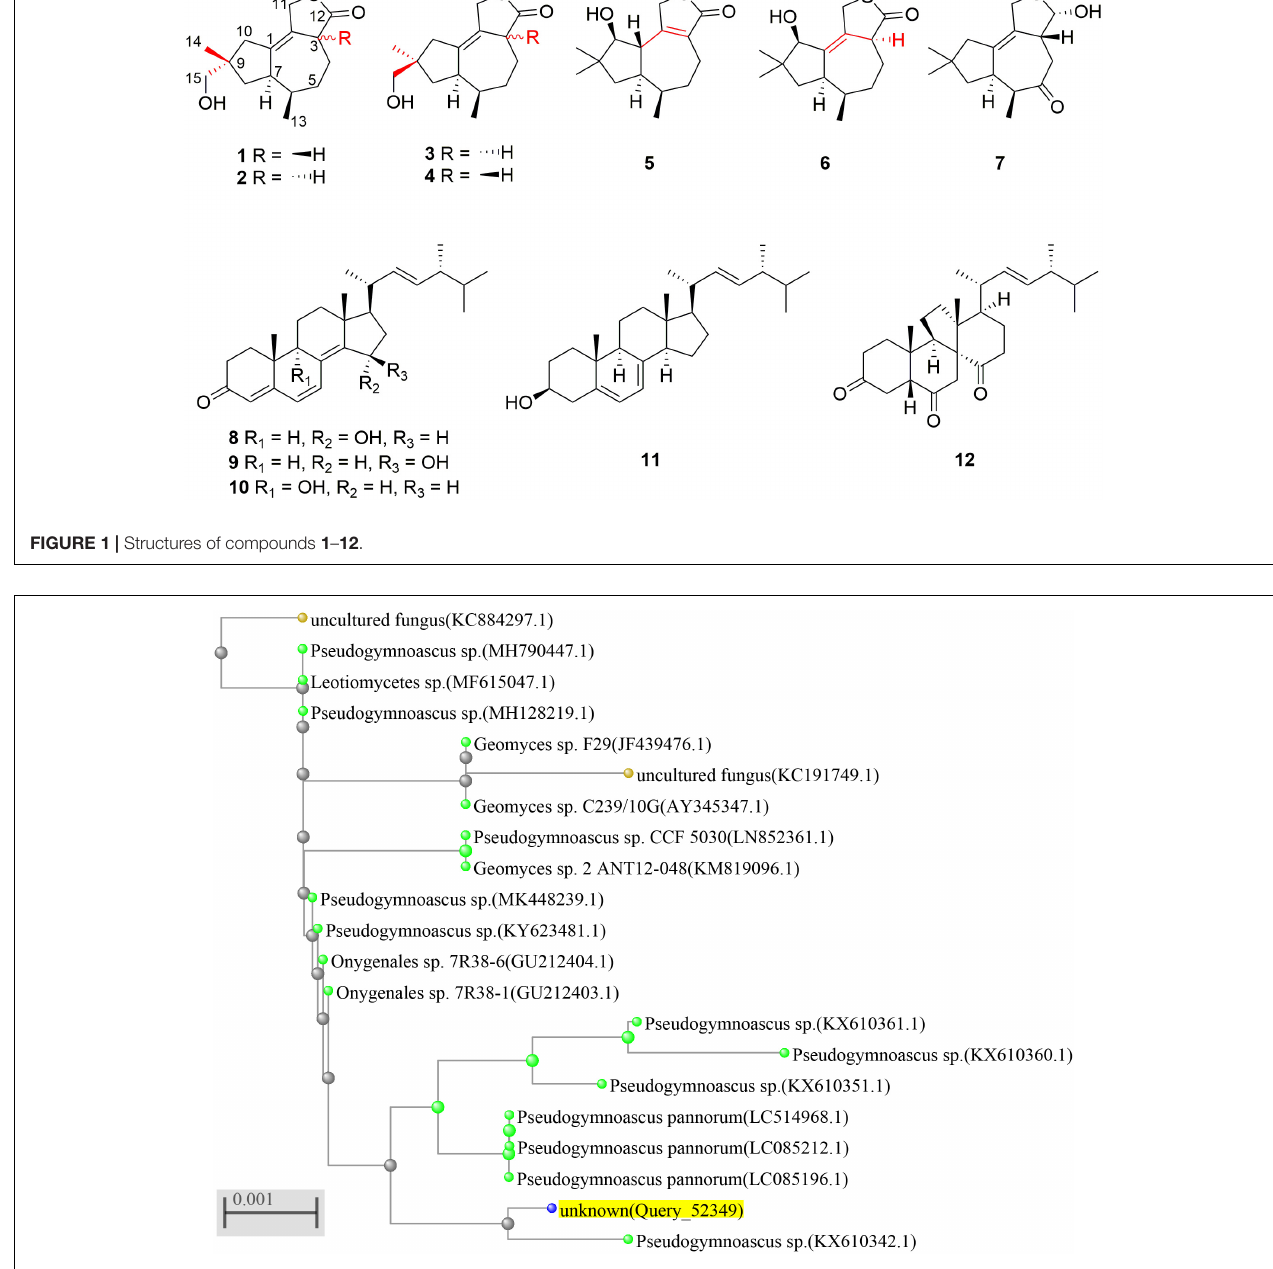
FIGURE 2 | Phylogenetic tree of the fungus Pseudogymnoascus sp. HSX2#-11.